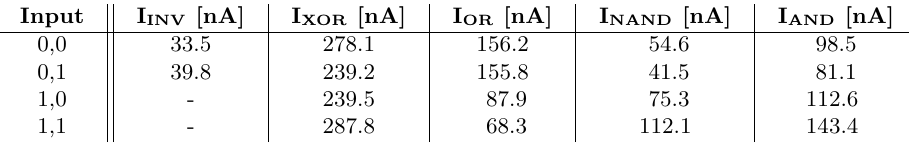
Table 2: Fictional input-dependent leakage currents of different logic gates.